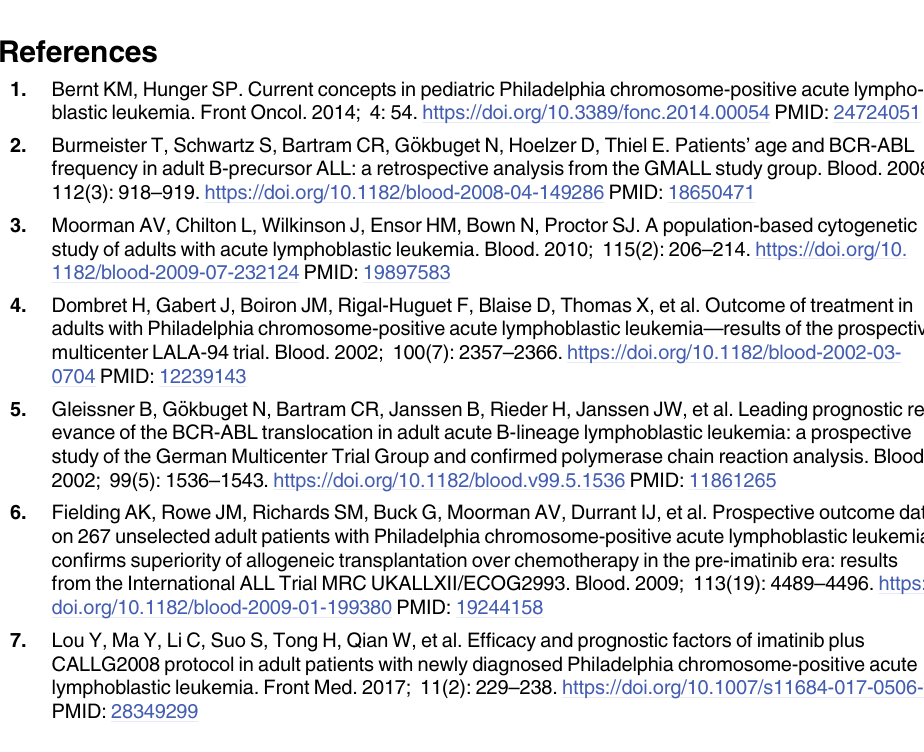
S1 Table. Characteristics of the studies included in this meta-analysis. S2 Table. Quality assessment of the included studies using the QUIPS tool. S3 Table. Subgroup analyses of the impact of MRD status on the prognoses of Ph+